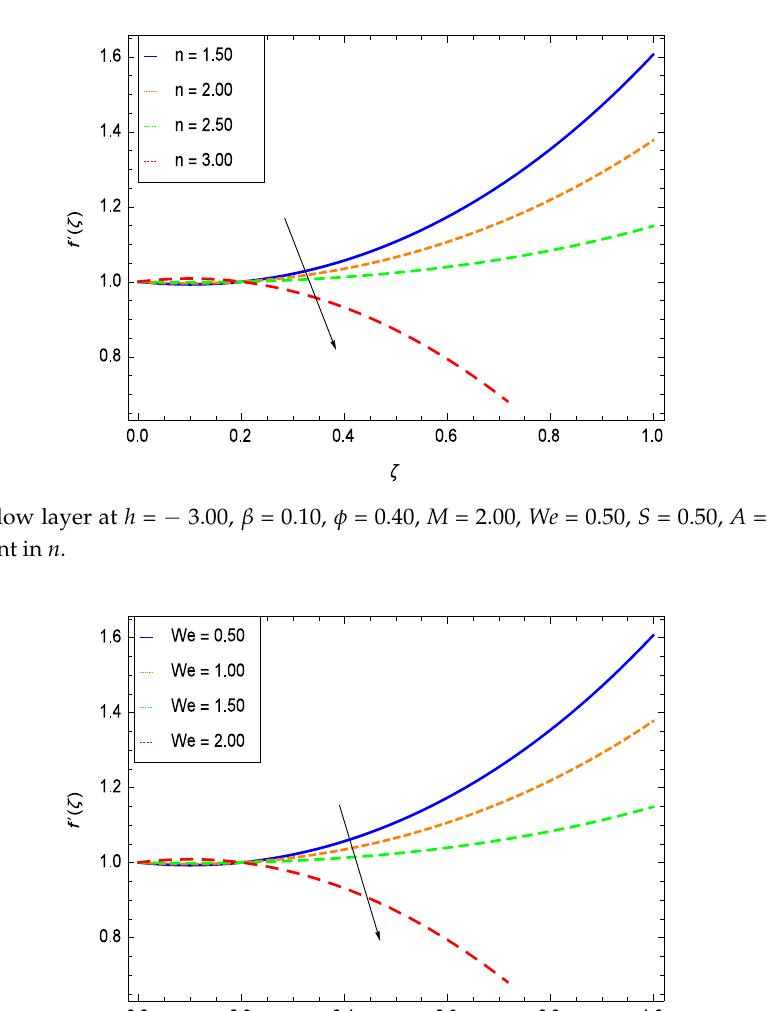
Figure 7. Flow layer at h = − 3.00, β = 0.10, φ = 0.40, n = 1.50, We = 0.50, S = 0.50, A = π enhancement in M .